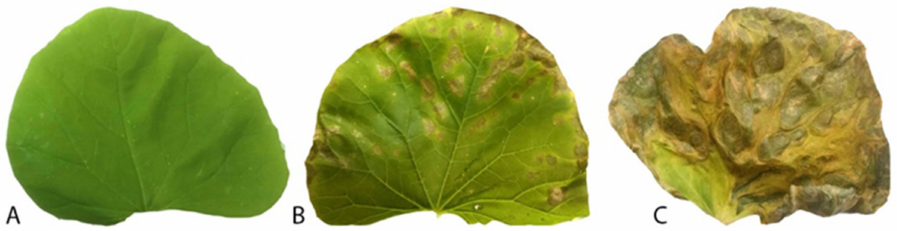
Figure 1. Temporal sequence of Boron (B) toxicity leaf symptomatology. Mature leaves (close to the root-to-shoot intersection) of Armenian cucumbers ( C. melo var. flexuosus cv. Abruzzese Tortarello) were imaged under oversupply of B (by using H 3 BO 3 ). ( A ) No visible symptoms (1 mM B-treated plants sampled at 35 d); ( B ) Less severe symptoms (1 mM B-treated plants sampled at 40 d); ( C ) Severe symptoms (1 mM B-treated plants sampled at 45 d).